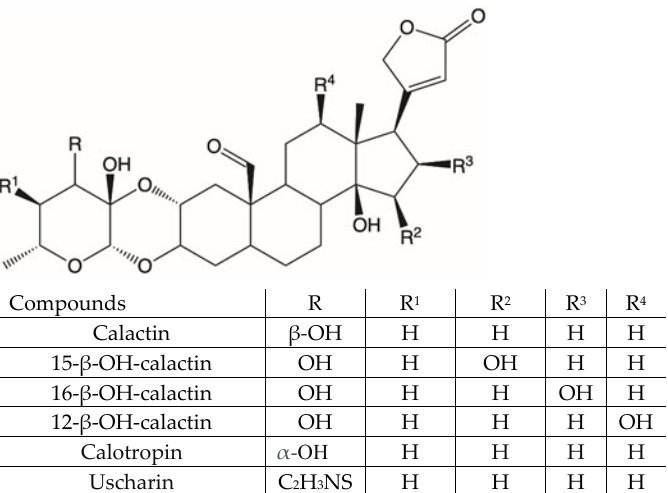
Figure 1. Cardenolides isolated from Calotropis procera leaves.